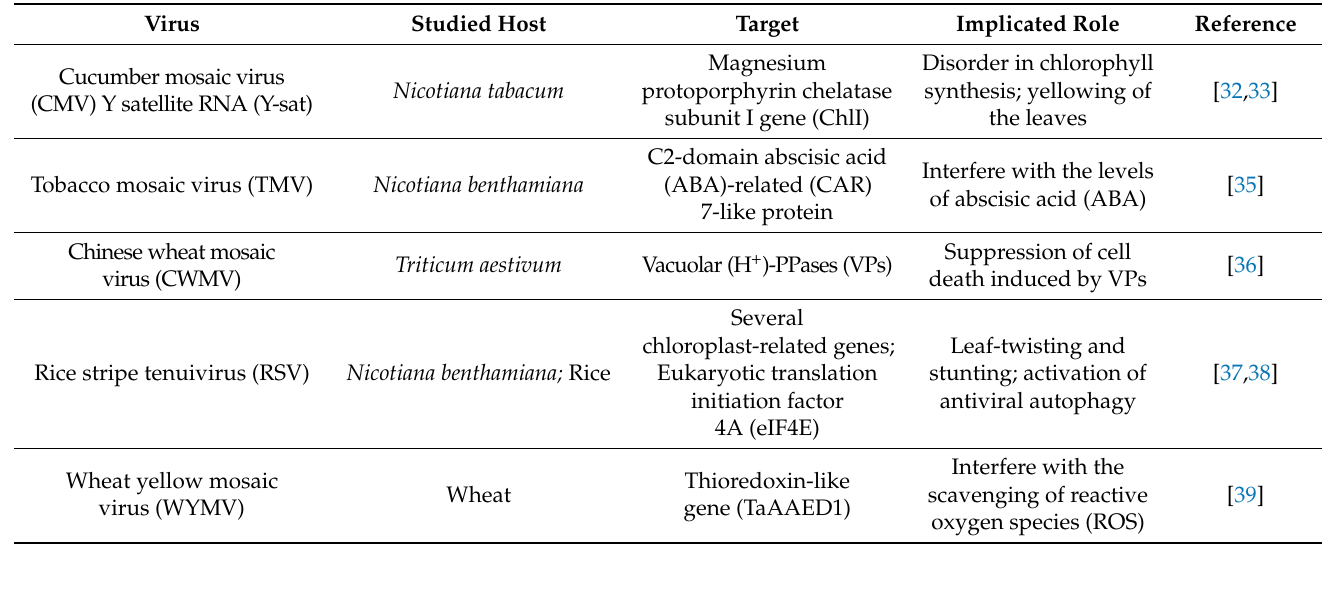
Table 1. Studies that have demonstrated evidence of plant virus-derived trans-acting sRNAs with implicated roles in the viral–host interplay.